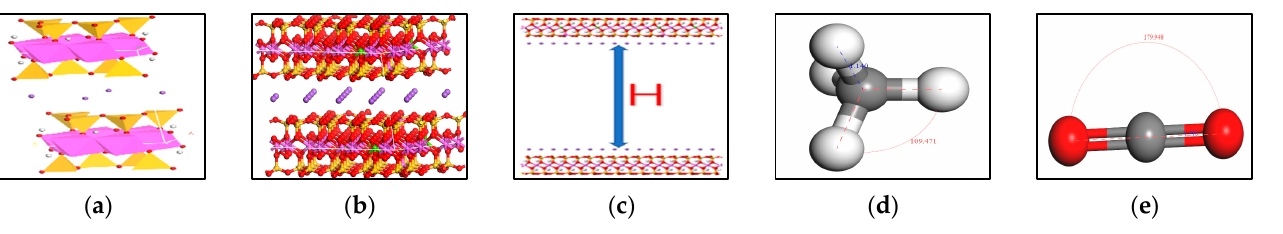
Figure 1. Molecular model diagram of competitive adsorption of CH 4 and CO 2 in sodium-based montmorillonite ( a ): Sodium-based montmorillonite crystal, ( b ): Sodium-based montmorillonite supercell crystal, ( c ): Montmorillonite slit, ( d ): Methane model, ( e ): Carbon dioxide model. Table 1. Spatial coordinates of each atom and cation in the cell.